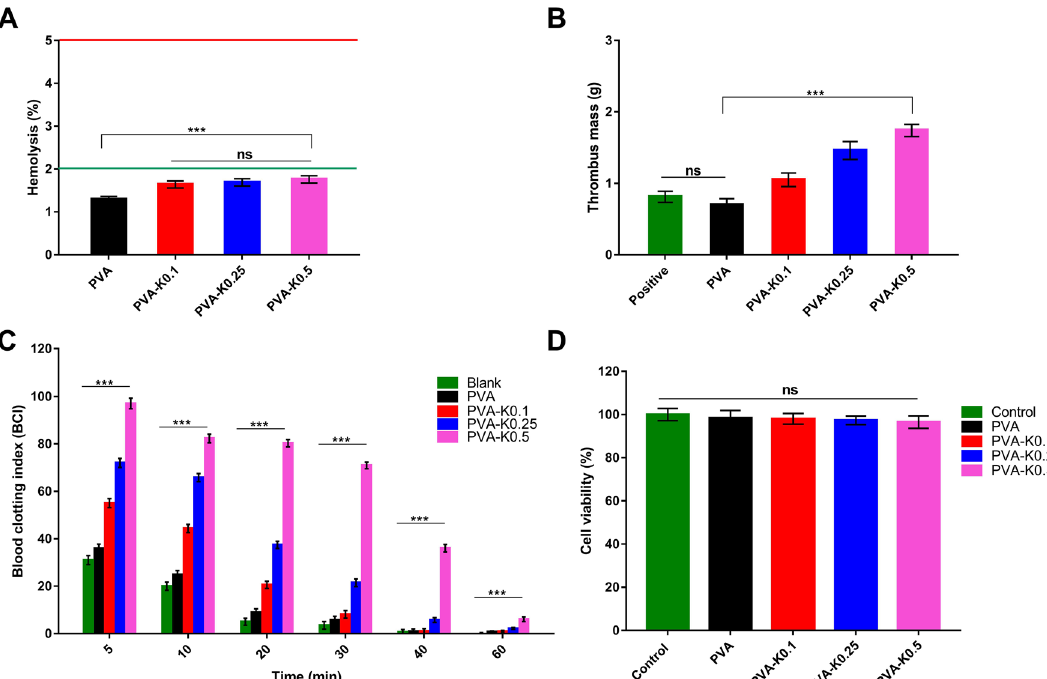
Figure 8. ( A ) Hemocompatibity, ( B ) thrombogenicity, ( C ) blood clotting index, and ( D ) cytotoxicity for PVA hydrogel membrane and PVA/Kaolin composite hydrogel membranes. Data are expressed as means ± SD [***p < 0.001, while (ns) indicates non-significant